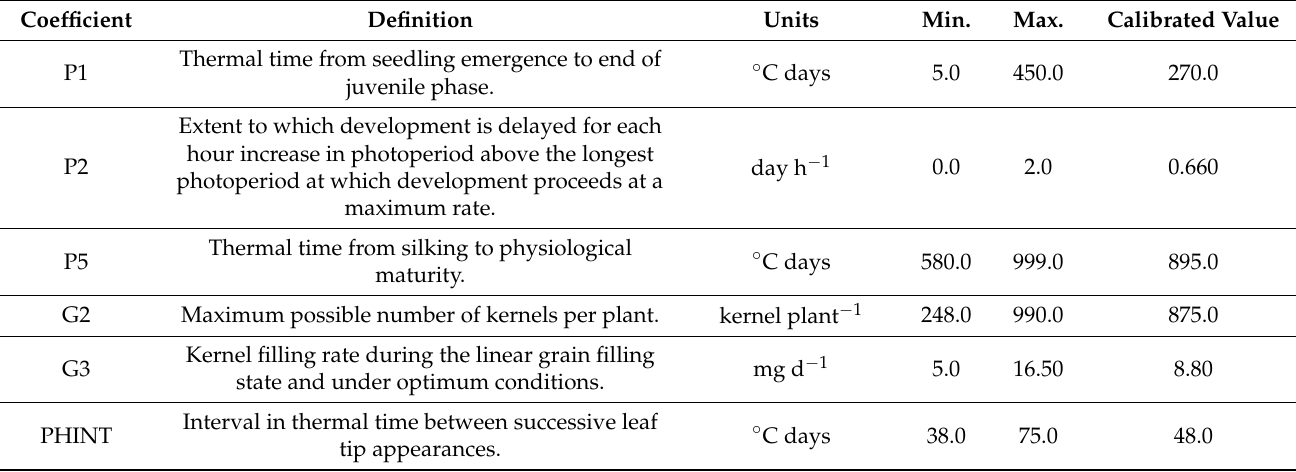
Table 2. Estimated cultivar coefficients for the CERES-Maize